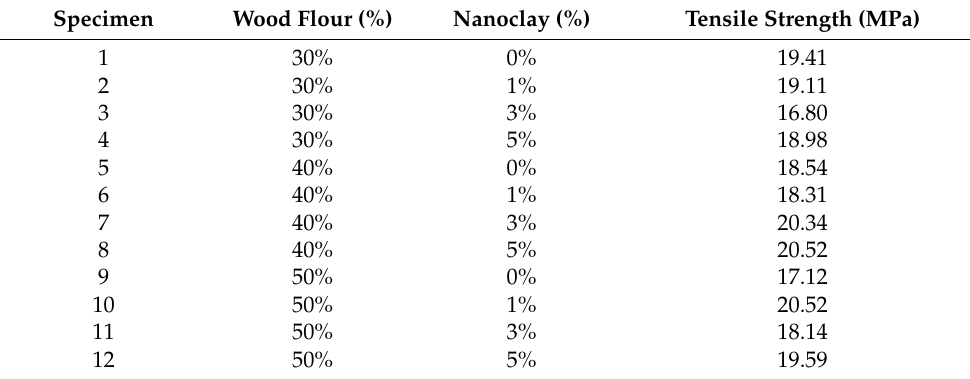
Table 7. Impact of nanoclay on tensile strength.